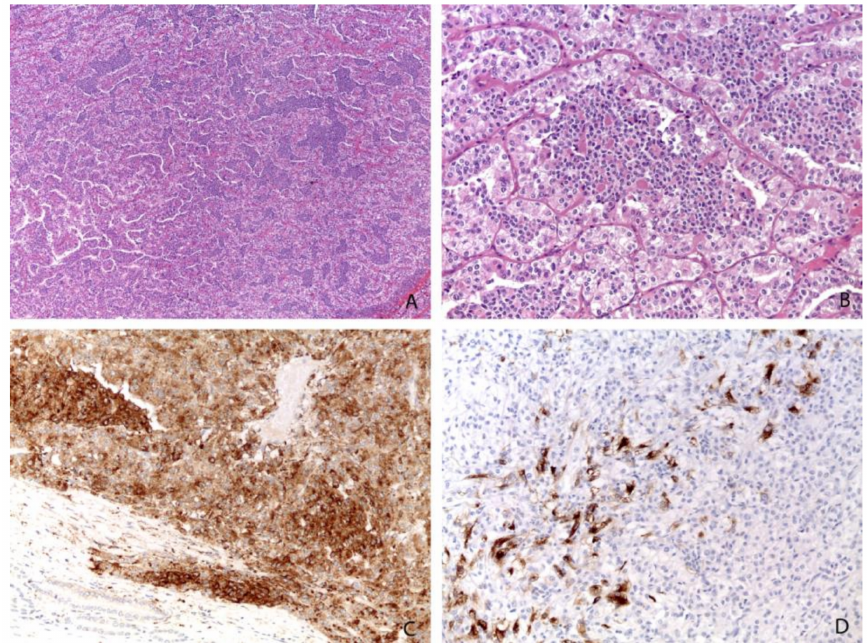
Figure 3. The most common morphology of t(6;11) renal cell carcinoma with larger epithelioid cells and smaller cells clustered around eosinophilic spheres formed by basement membrane material ( A , Magnification: 25 × ; B , Magnification: 200 × ). Almost all cases are positive for cathepsin K (Magnification: 200 × ) ( C ) and HMB45 (Magnification: 200 × ) ( D